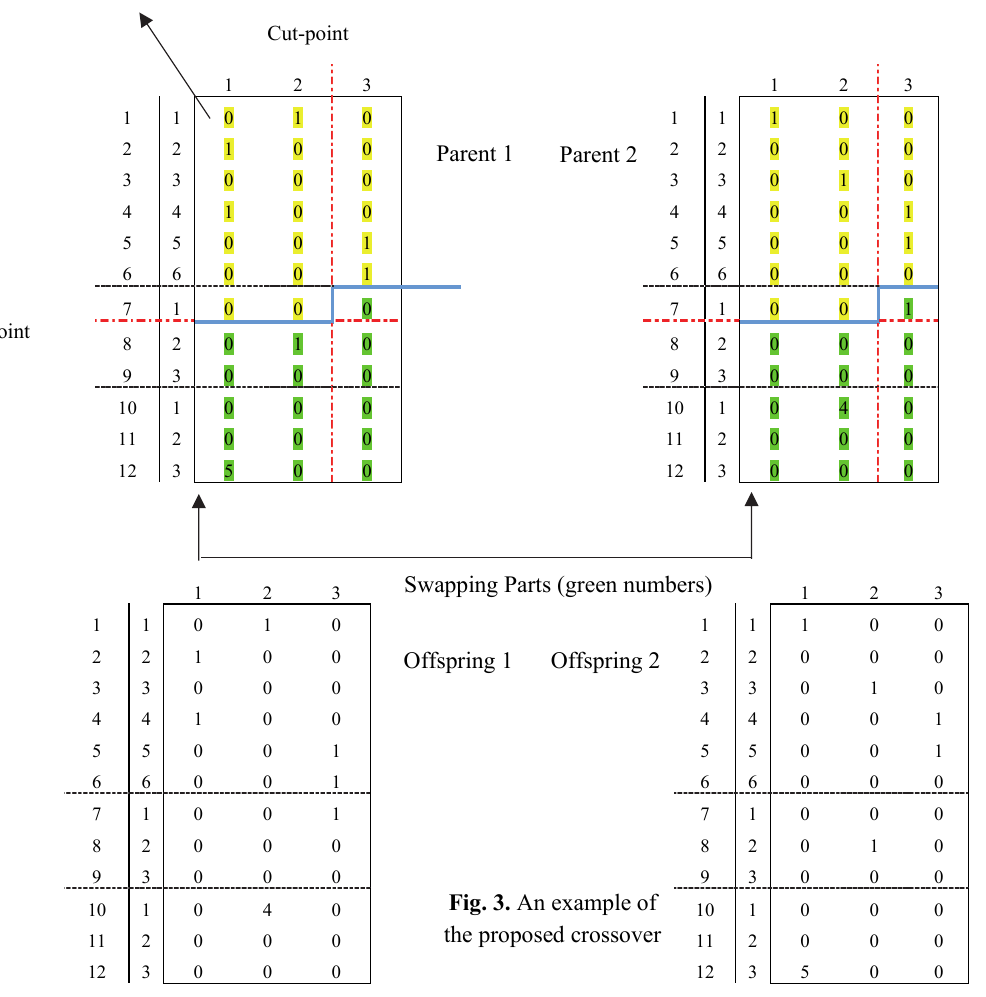
Fig. 3. An example